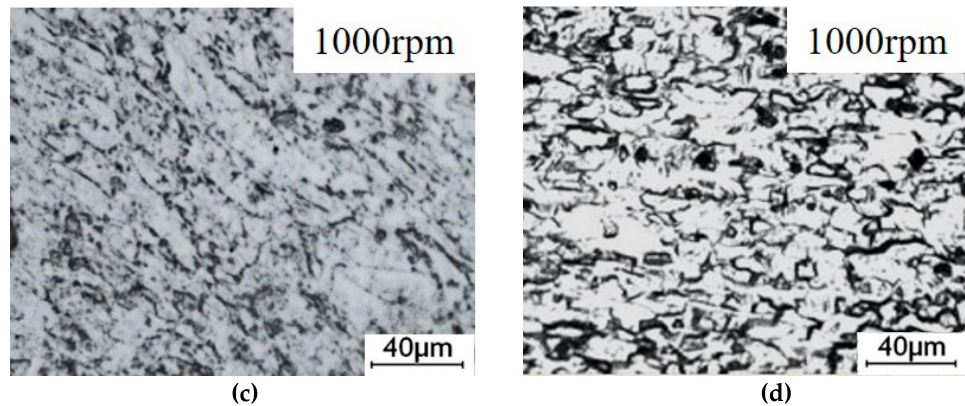
Figure 8. The microstructure of the Al alloy of the keyhole-free FSSW joint: ( a ) WNZ, ( b ) TMAZ, ( c ) HAZ, and ( d ) BM.